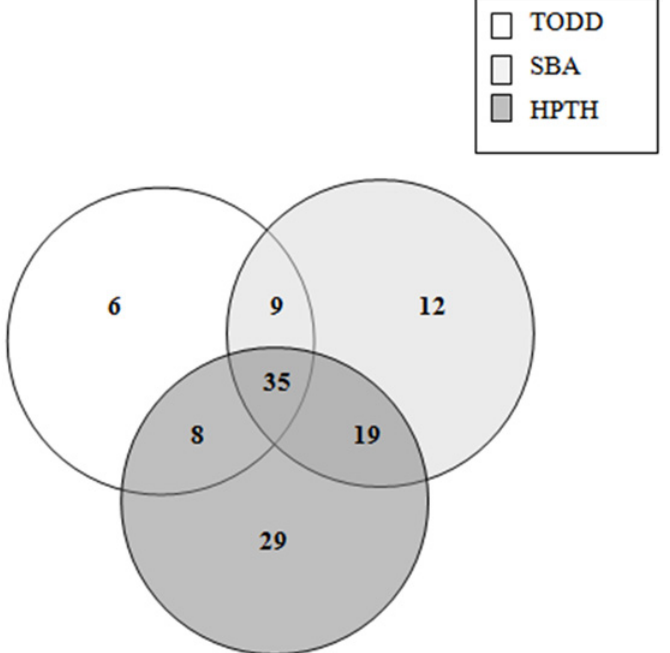
Fig 1. Number of Streptococcus agalactiae positive pregnant women (35 – 37 weeks of gestation) detected by HPTH medium, Todd-Hewitt enrichment broth (TODD), and sheep blood agar (SBA) plating in vaginal